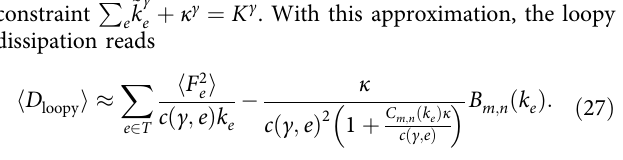
Here, we de fi ned the quantities B m , n ( k e ) and C m , n ( k e ) which we obtain from B m , n and C m , n (Eq. (24)) by replacing the updated ~ capacity k by the tree capacity k e . The last expression can then be e simpli fi ed considerably by making use of Eq. (3),